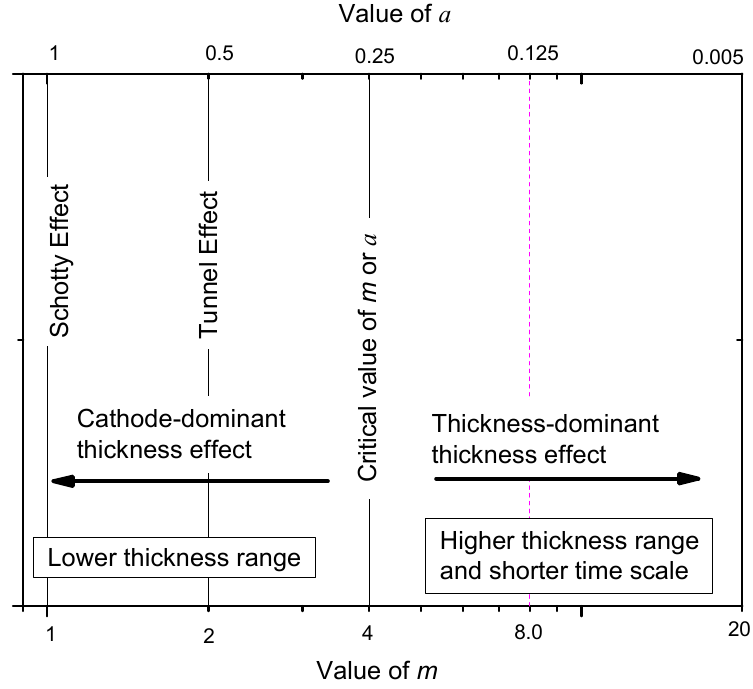
Figure 12. Di ff erent breakdown mechanisms for di ff erent values of m betrayed by the minus power Figure 12. Different breakdown mechanisms for different values of m betrayed by the minus power relation.